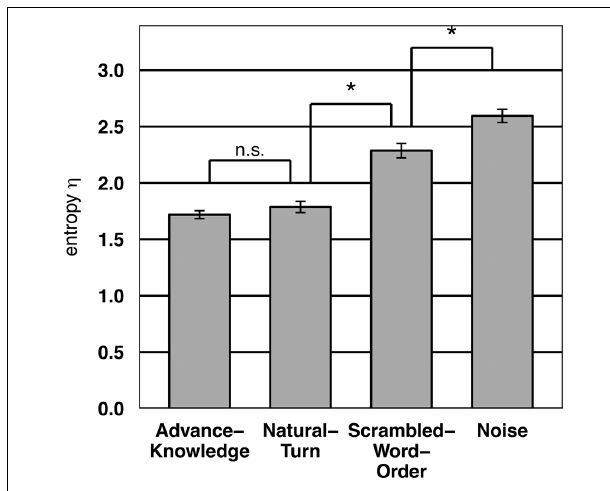
FIGURE 4 |Average Shannon Entropy per stimulus/condition as measured in Experiment 1. Asterisk indicates statistical significance at the 0.05